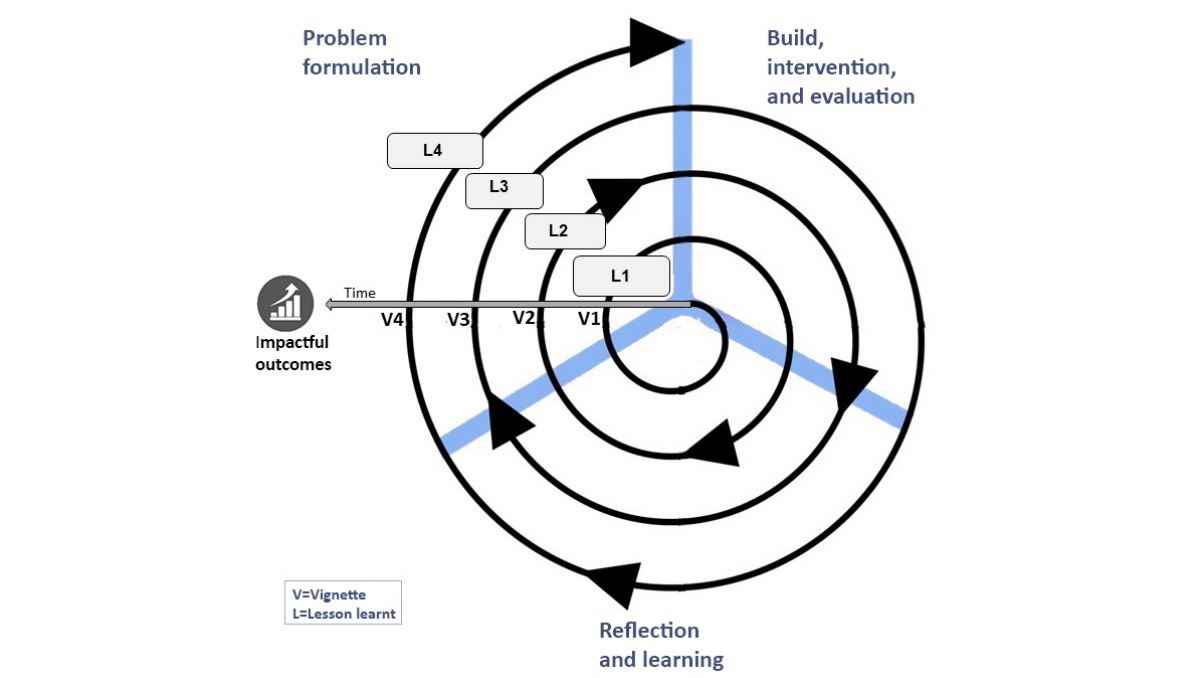
Figure 4. Visualisation of reflection within the context of the ADR project, where V=vignette and L=lesson